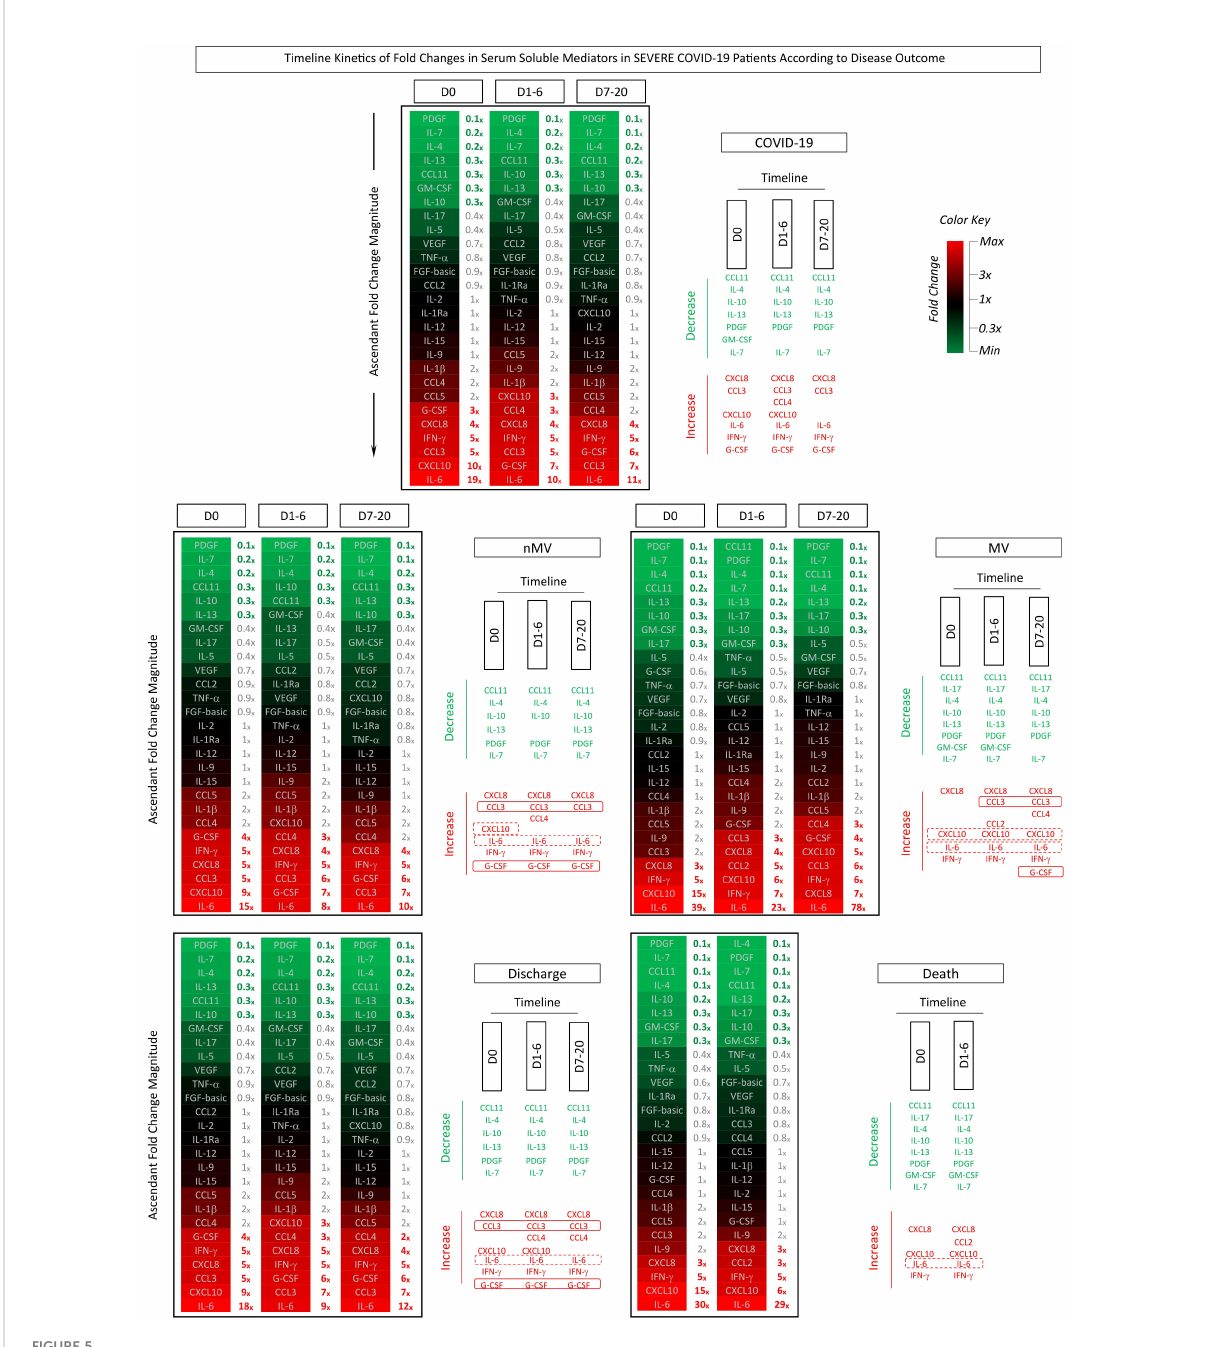
FIGURE 5 Timeline kinetics of fold changes in serum soluble mediators in severe COVID-19 patients according to disease outcome . The fold changes in serum chemokines (CXCL8, CCL11, CCL3, CCL4, CCL2, CCL5, CXCL10), pro-in fl ammatory cytokines (IL-1 b , IL-6, TNF- a , IL-12, IFN- g , IL-15, IL -17), regulatory cytokines (IL-1Ra, IL-4, IL-5, IL-9, IL-10, IL-13) and growth factors (FGF-basic, PDGF, VEGF, G-CSF, GM- CSF, IL-2, IL-7) were assessed along the kinetic timeline follow-up after admission (D0, D1-6 and D7-20) in COVID-19 patients (n=82), further categorized into subgroups according to disease outcome, referred to as: Non-Mechanical Ventilation (nMV, n=71) vs Mechanical Ventilation (MV, n=11), and Discharge (n=75) vs Death (n=7). Serum soluble mediators were measured by high-throughput multiplex bead array as described in Material and Methods. The results are presented as the proportion of levels observed for each COVID-19 patient along the kinetic timeline follow-up divided by the median values reported for non-infected pre-pandemic Healthy Controls (HC, n=164). Data are presented in heatmap constructs illustrating the ascendant signature of fold change magnitudes along the kinetic timeline. A color key was used to underscore the attributes with decreased (fold change <1x, towards green), unaltered (fold change =1x, black) or increased levels (fold change >1x, towards red. Further analysis was carried out by timeline diagrams to identify common and selective soluble mediators (rectangles) with decreased ( ≤ 0.3x, green) or increased ( ≥ 3x, red) levels along the kinetic timeline. Serum soluble mediators of good (nMV and Discharge) or poor prognosis (MV and Death) are highlighted by continuous or dashed rectangles,